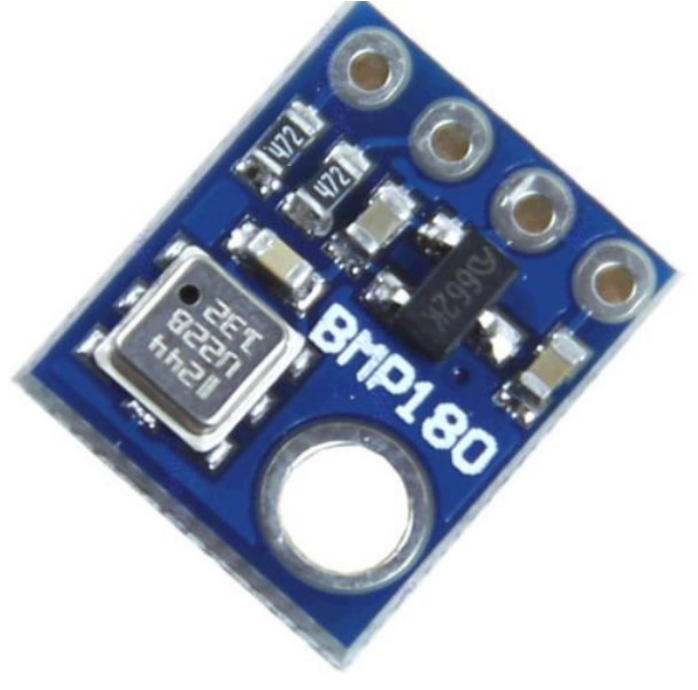
Figure 12. BMP180 pressure sensor.